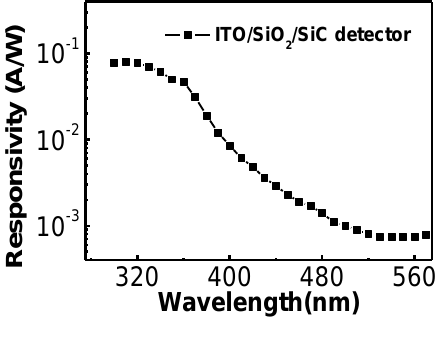
Figure 7. Spectral responsivity of the ITO/SiO UV (310 nm)-to-visible (500 nm) rejection ratio was ~80. Reproduced from [31] with permission of Elsevier